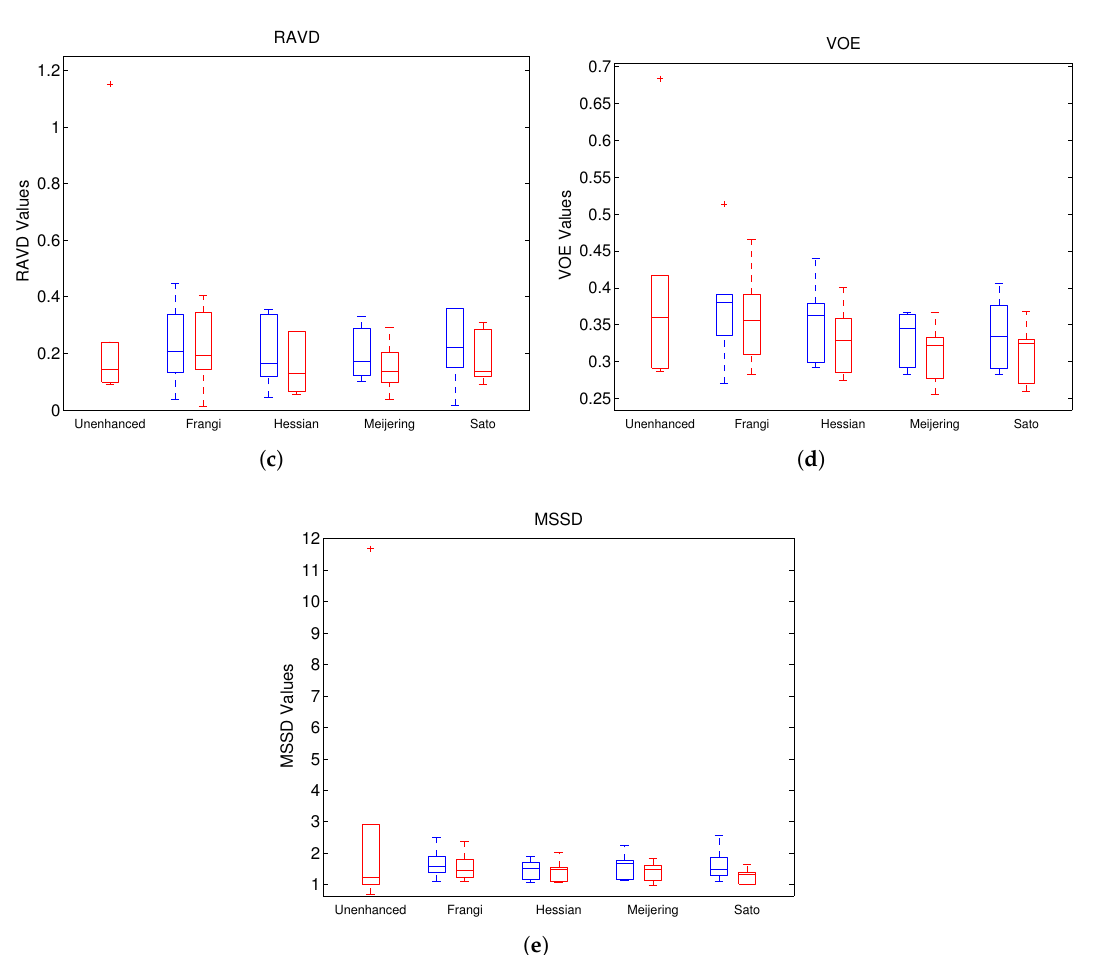
Figure 8. Comparison of segmentation of unenhanced (first red) and filtered images without (blue) and with (red) Gamma correction. ( a ) DICE; ( b ) ASSD; ( c ) RAVD; ( d ) VOE; ( e )